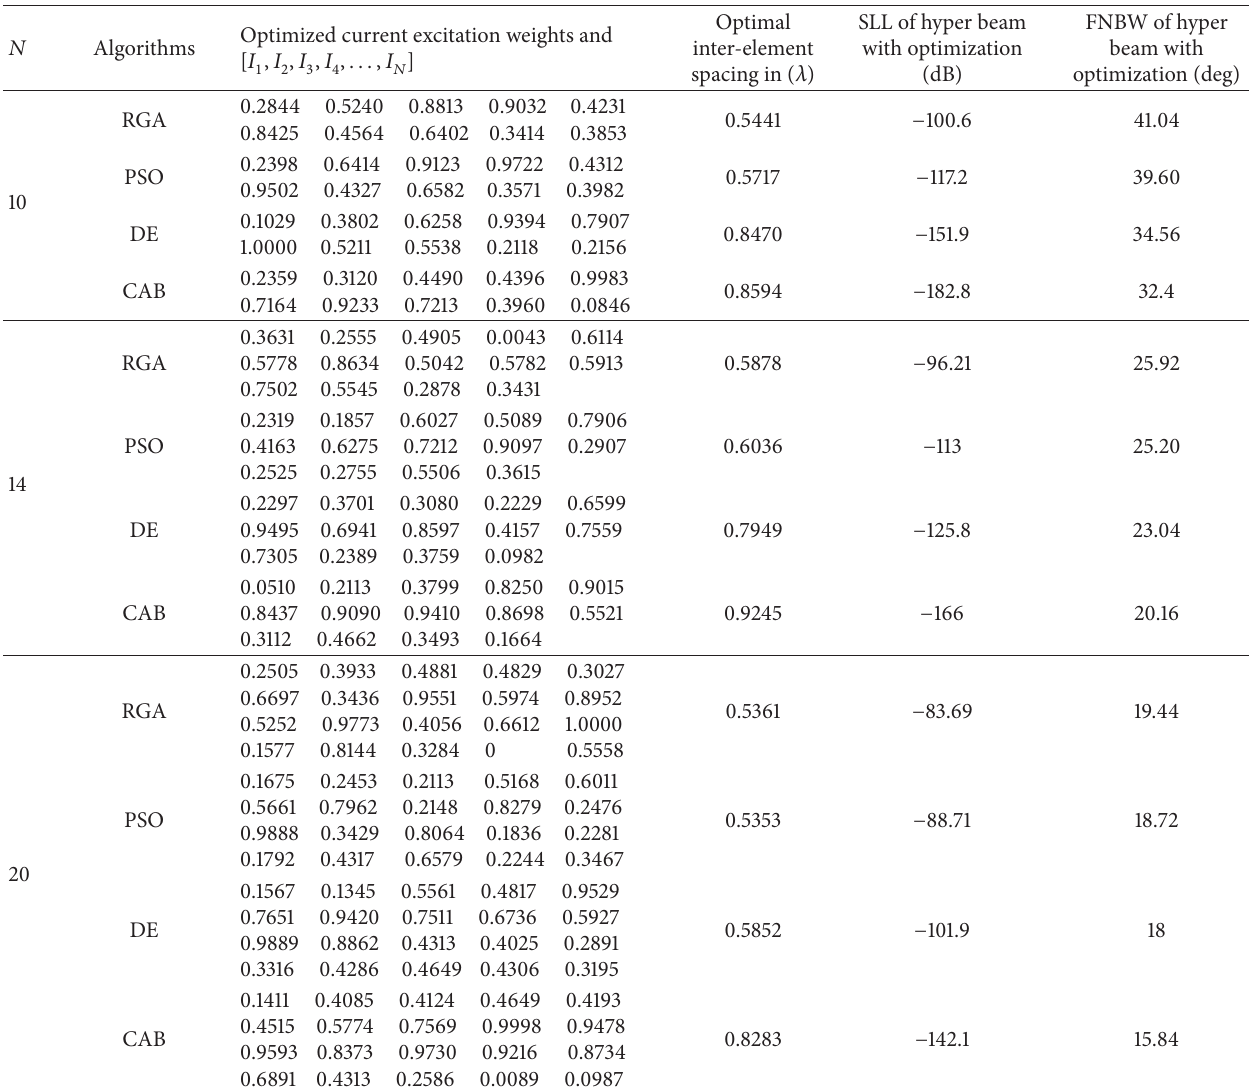
Table 3: SLL, FNBW, optimal current excitation weights, and optimal inter-element spacing for hyper beam pattern of linear array with hyper beam exponent ( 𝑢 = 0.5 ), obtained by RGA, PSO, DE, and CAB for different sets of arrays. 𝑁 Algorithms Optimized current excitation weights and